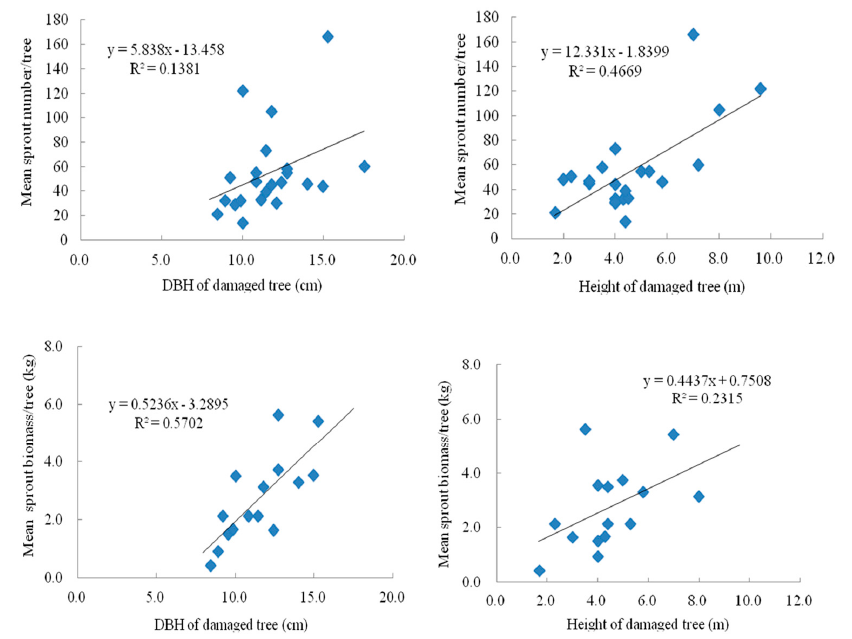
Figure 13. Regression analyses of diameter at breast height and height of sampled damaged tree on the sprout number / tree and total sprout biomass / tree of three damaged types trees, respectively in 2010 year.